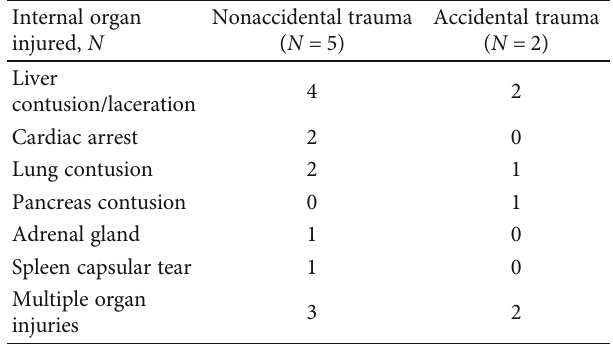
Table 4: Internal organ injury presentations in NAT and AT. Internal organ